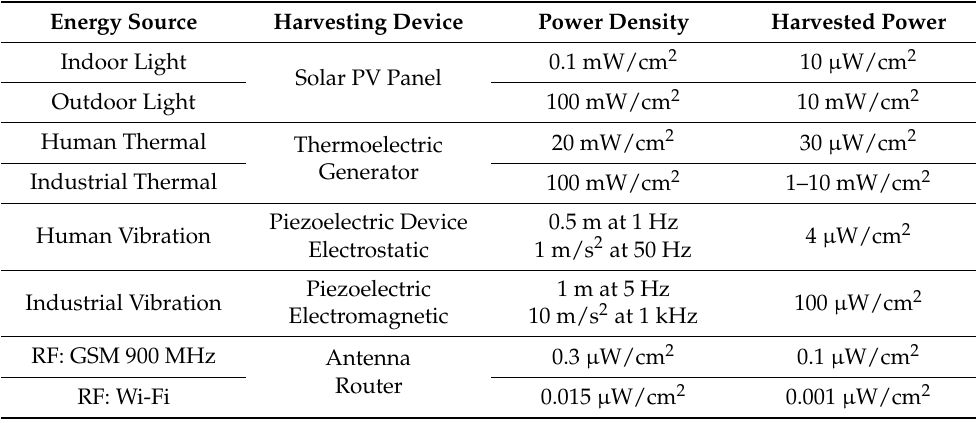
Table 3. The extracted power produced from the familiar ambient sources